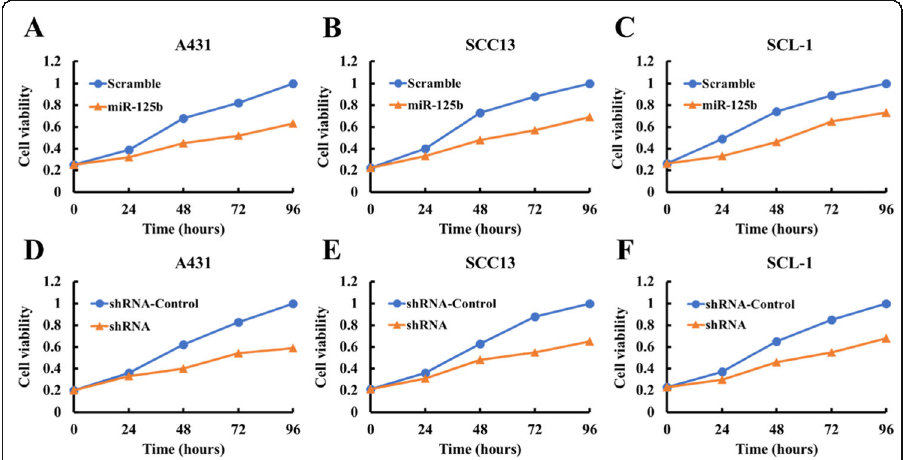
Fig. 3 The knockdown of STAT3 inhibits CSCC cell proliferation. This was assessed using the MTT assay. a , b and c STAT3 knockdown by miR-125b mimics inhibits A431, SCC13 and SCL-1 cell proliferation. d , e and f STAT3 knockdown by shRNA inhibits A431, SCC13 and SCL-1 cell proliferation. Data are the means ± SD of three independent